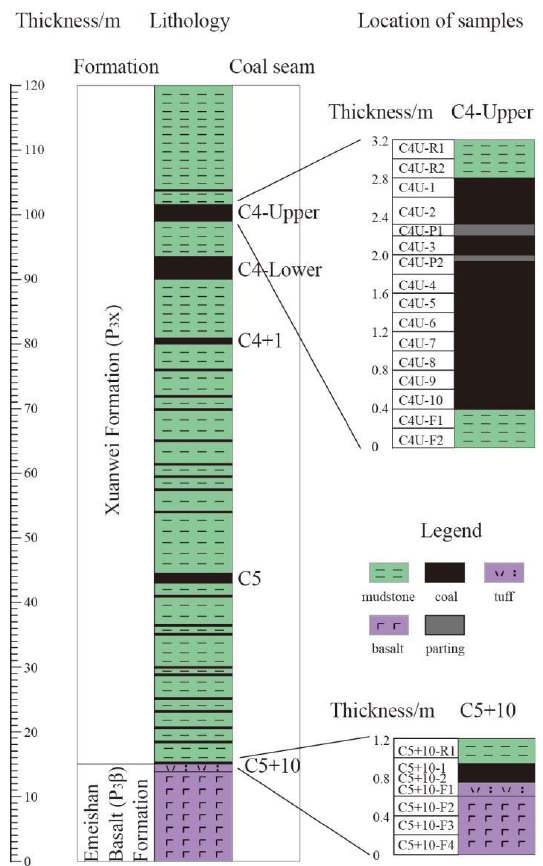
Figure 2. Stratigraphic sequence of the Feilongma mine and the Shipeng mine and sample location (modified from Zhang et al. [19] and Yang et al. [20]).